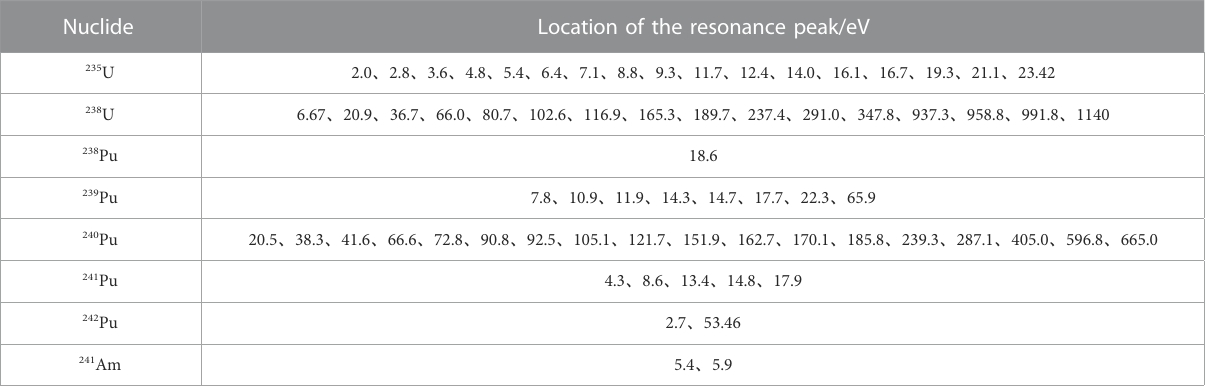
TABLE 1 Distributions of main resonance peaks of typical actinide nuclides. Nuclide Location of the resonance